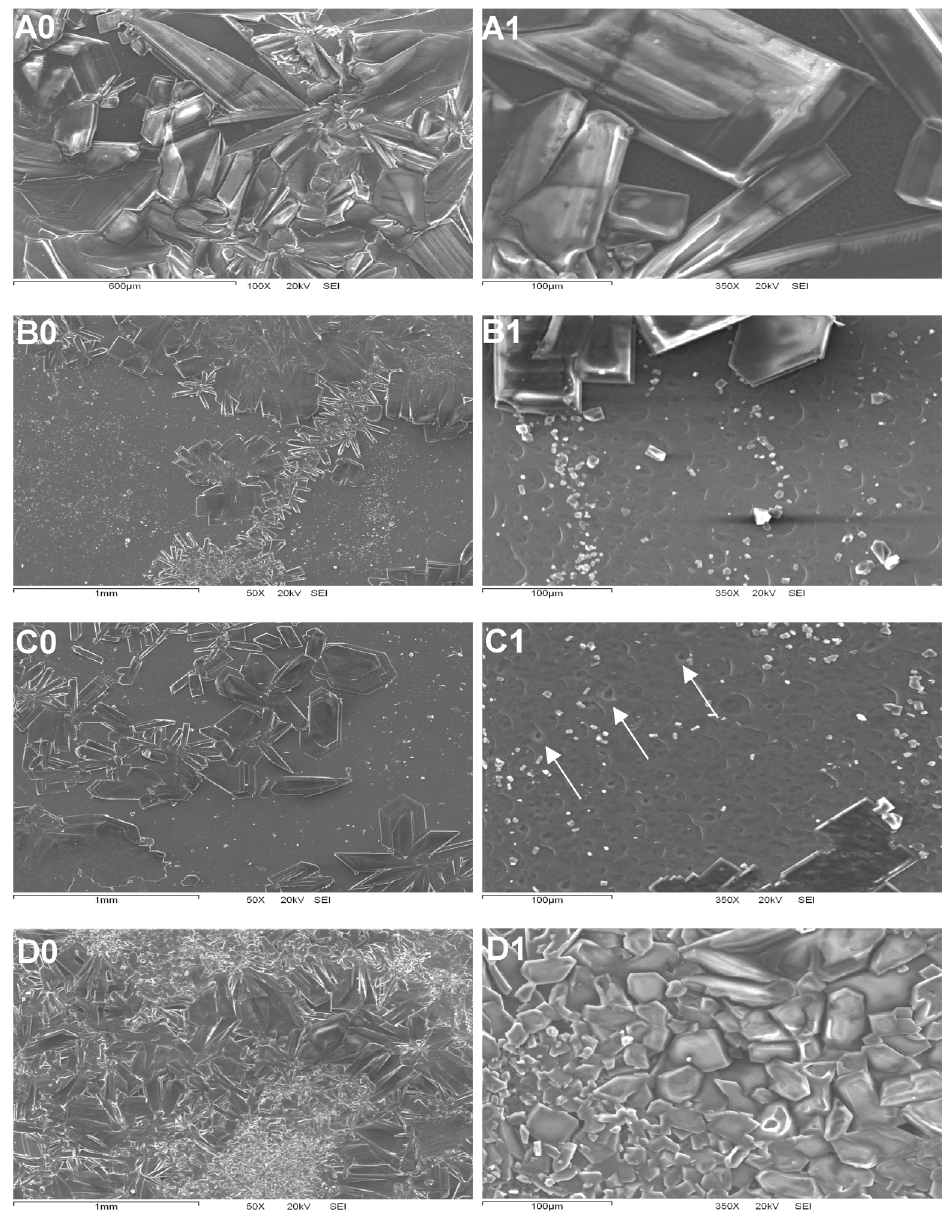
Figure 3. SEM images of PEC membranes: control PEC membranes only with T80 1.0% (A0 and A 1), PEC-CAR 0.25% (B0 and B1), PEC-CAR 0.50% (C0 and C1) and PEC-CAR 1.00% (D0 y D1) (Each one of them were amplified 50X and 350X, respectively). White arrows indicate the presence of hole on membrane